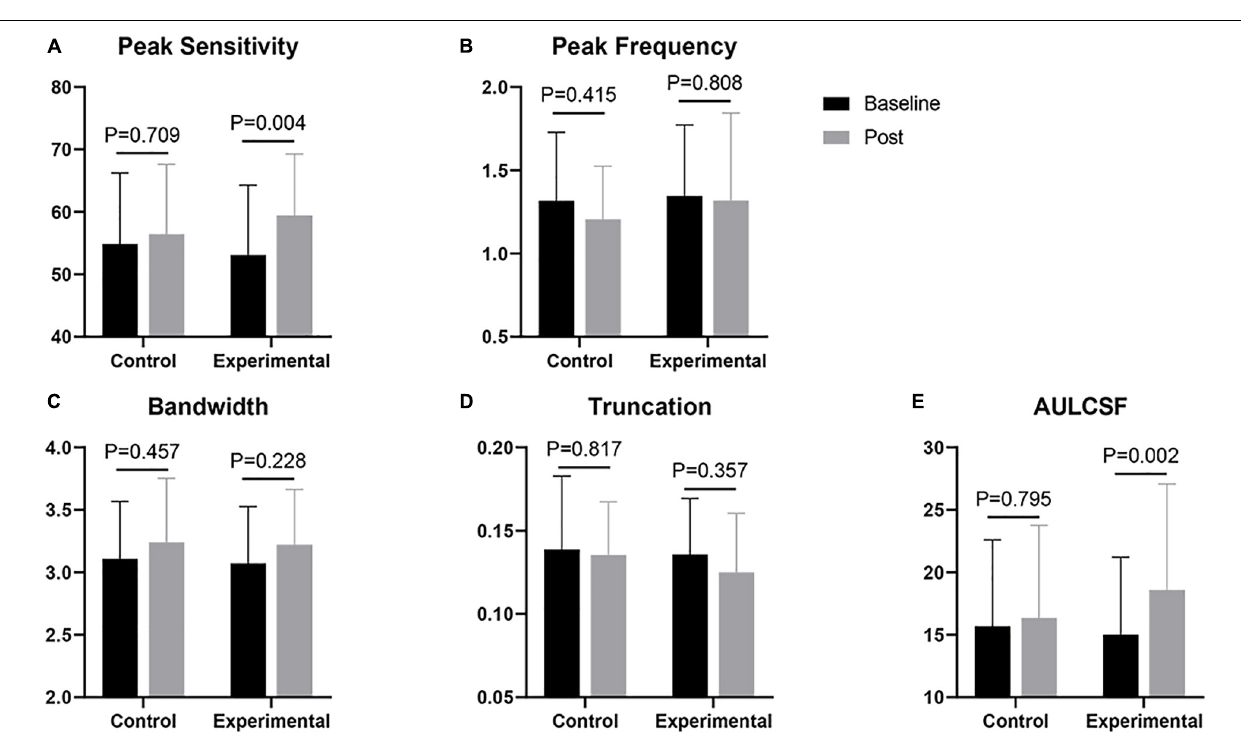
FIGURE 4 | Comparisons of CSF parameters between baseline and post. (A) Peak sensitivity; (B) Peak frequency; (C) Bandwidth; (D) Truncation; (E) AULCSF. The p -value shown in each panel corresponds to the result of a t